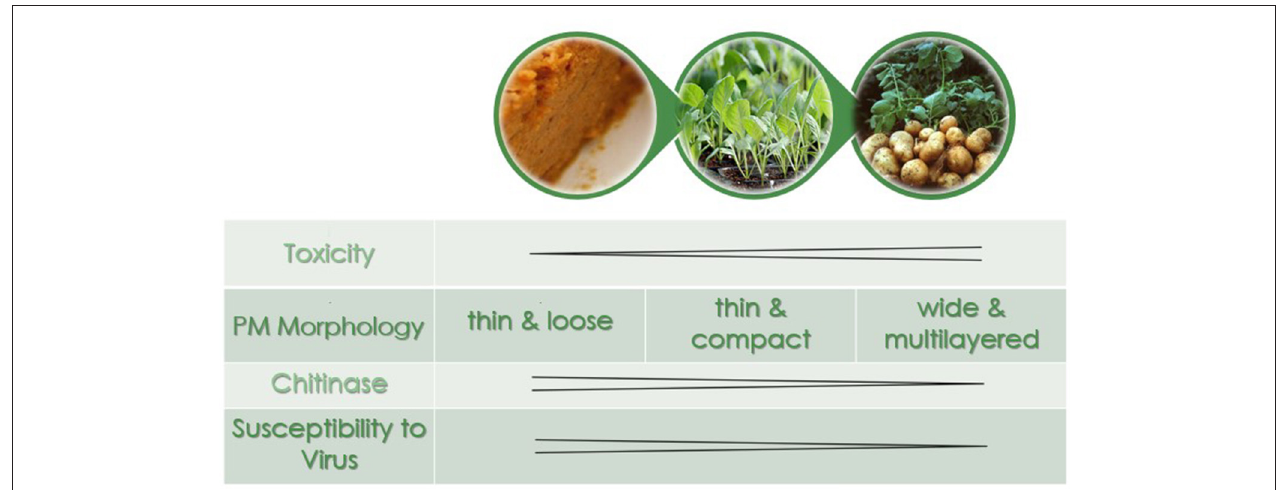
FIGURE 6 | The peritrophic matrix morphology, chitinase expression levels, and susceptibility to virus as a function of diet in 4th instar T. ni . In order of increasing toxicity are artificial diet, cabbage, and potato.